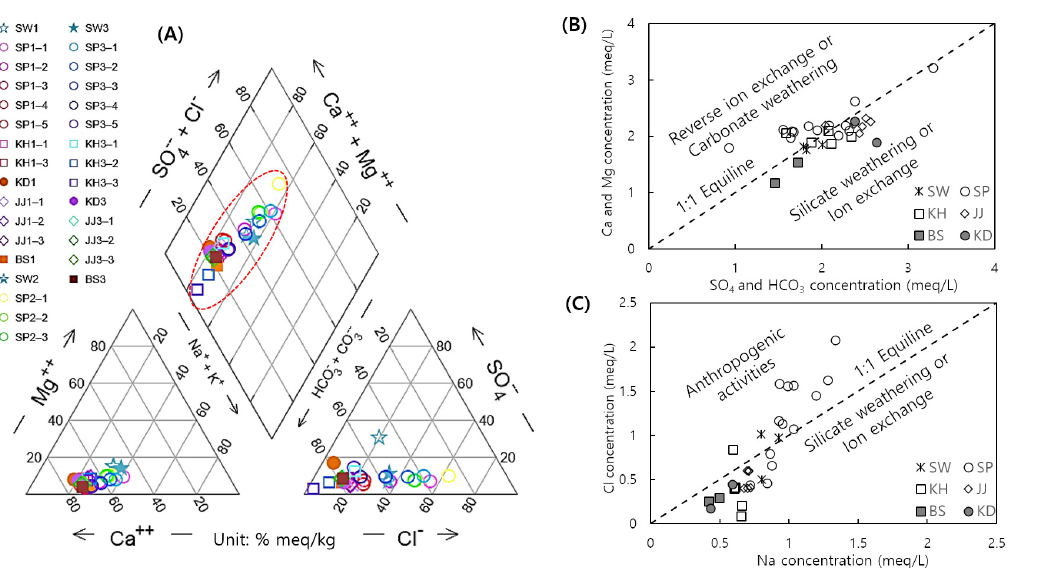
Figure 5. Piper diagram of all samples ( A ), (Ca+Mg) vs (SO 4 +HCO 3 ) diagram ( B ), and Cl vs. Na scatter diagram ( C